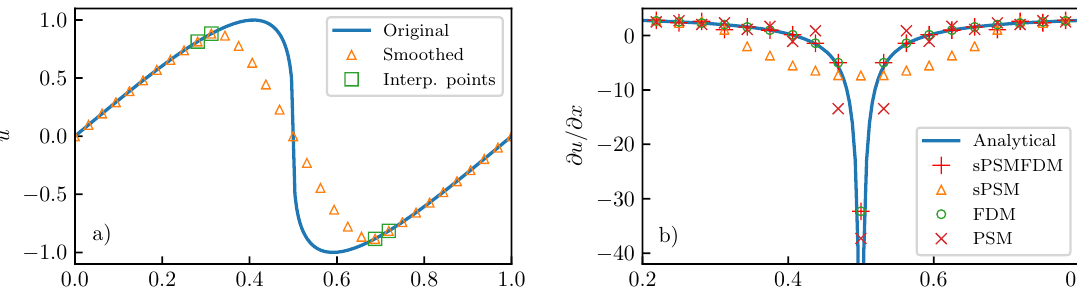
Figure 2. Illustration of the hybrid approach sPSMFDM. The velocity field at t = 0.159 for an initial value problem of 1D Burgers equation is shown in ( a ). The original velocity field is denoted by —, the smoothed field is denoted by , and the points for cubic interpolation are denoted by (cid:3) . The spatial (cid:52) derivative ∂ u / ∂ x is plotted in ( b ). The analytic solution is denoted by —, the result of the hybrid approach sPSMFDM is denoted by + . The result of PSM on a smoothed input (sPSM) is denoted by . (cid:52) The result of FDM for correction of sPSM is denoted by . The result of PSM on the original velocity ◦ field is denoted by for comparison. ×